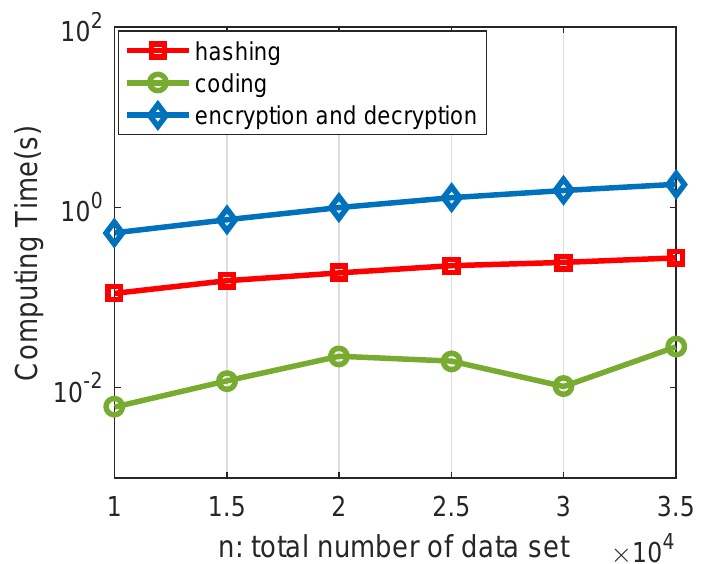
Figure 11. Computing time spent by different steps in